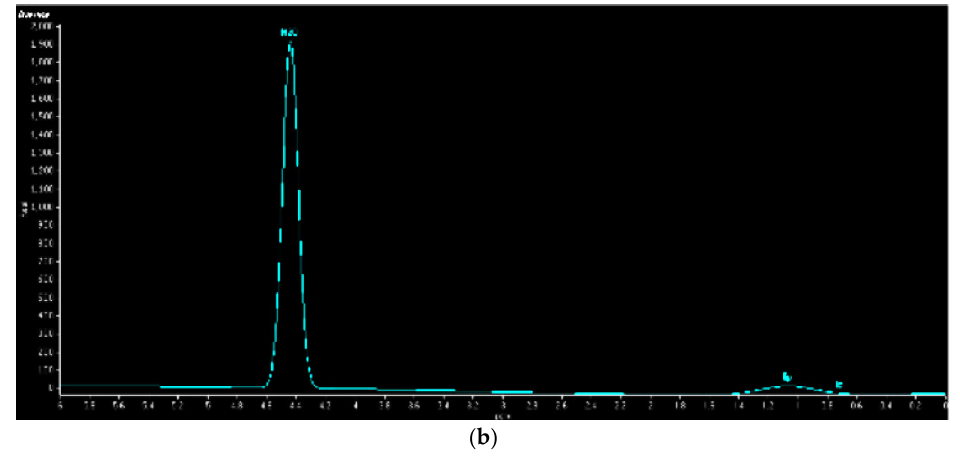
Figure 2. Typical spectra obtained from a NAFLD patient (( a ), IHL = 36.1%) and a healthy individual (( b ), IHL = 0.4%) showed the water signals and the lipid signals for calculating the IHL values.